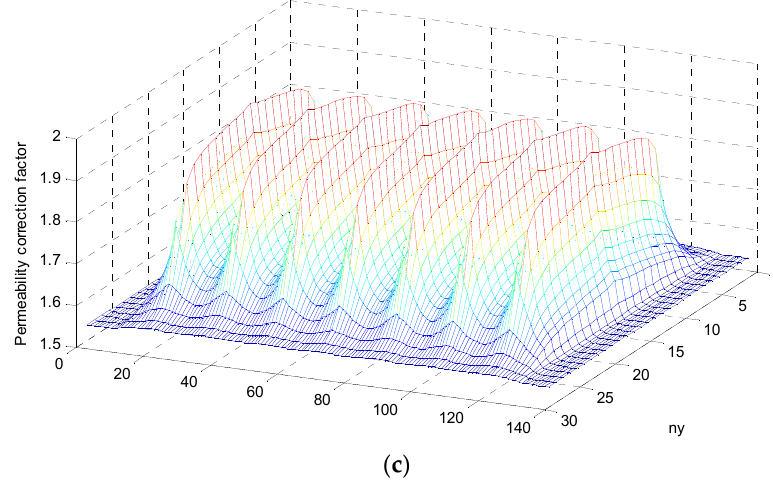
Figure 12. Distribution map of parameters in shale gas reservoir when K ∞ equals 6 × 10 −4 mD after 600 days (nx and ny represent the numbers of grid blocks in x direction and y direction respectively). ( a ) gas phase pressure; ( b ) Knudsen number; ( c ) permeability correction factor.